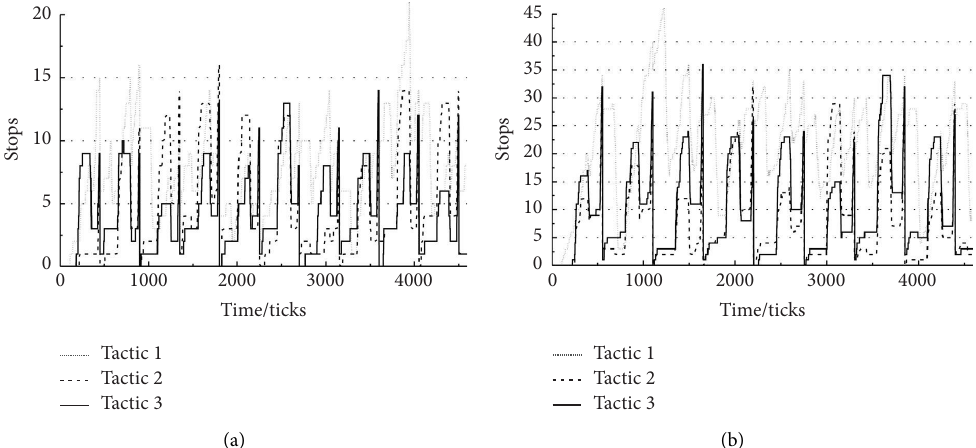
Figure 8: Comparison chart of stops with diferent control tactics: (a) the number of Stops during of-peak hours and (b) the number of Stops during peak hours.